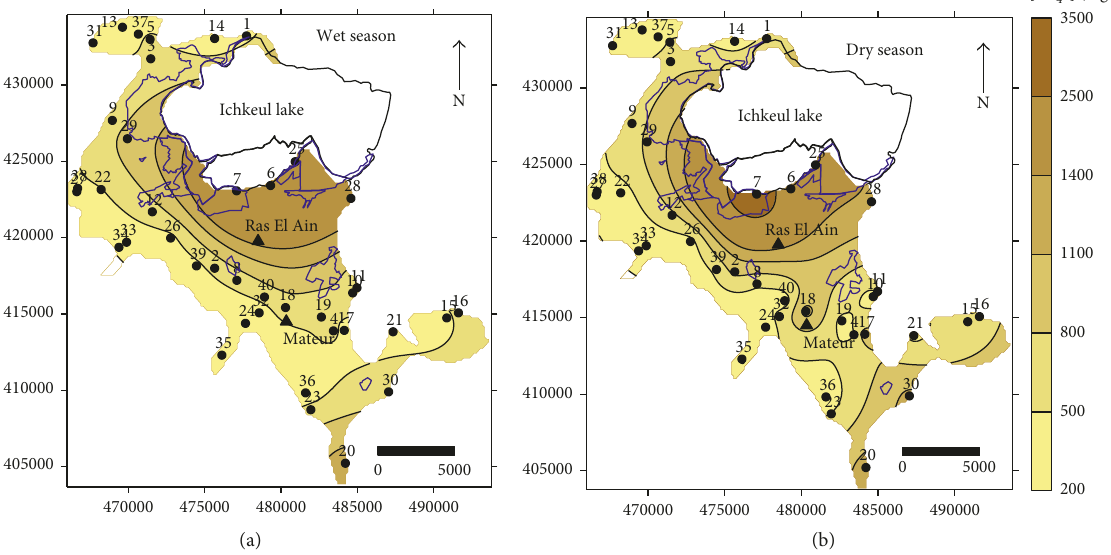
Figure 8: Spatial distribution maps of sulfate (SO